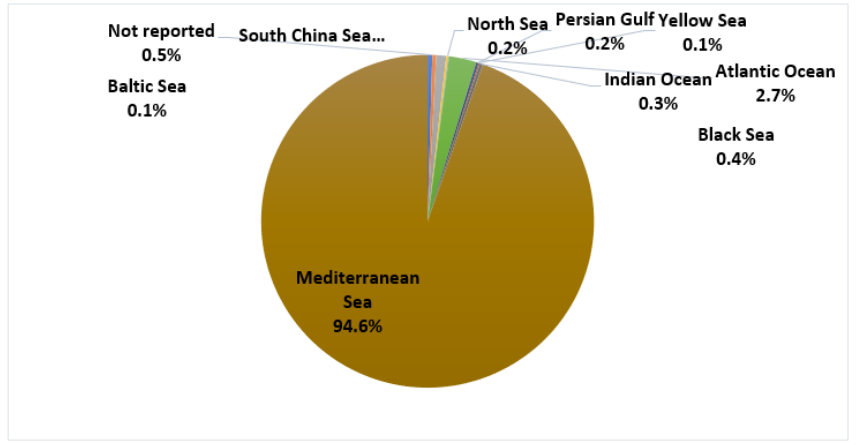
Figure 6. Percentages of BW discharged in the Port of Ploče by sea areas.